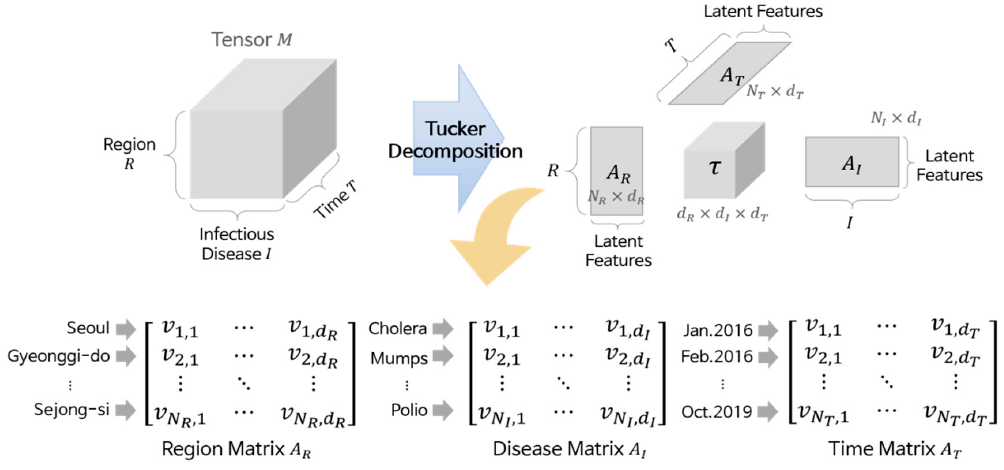
Figure 4. Tucker decomposition.